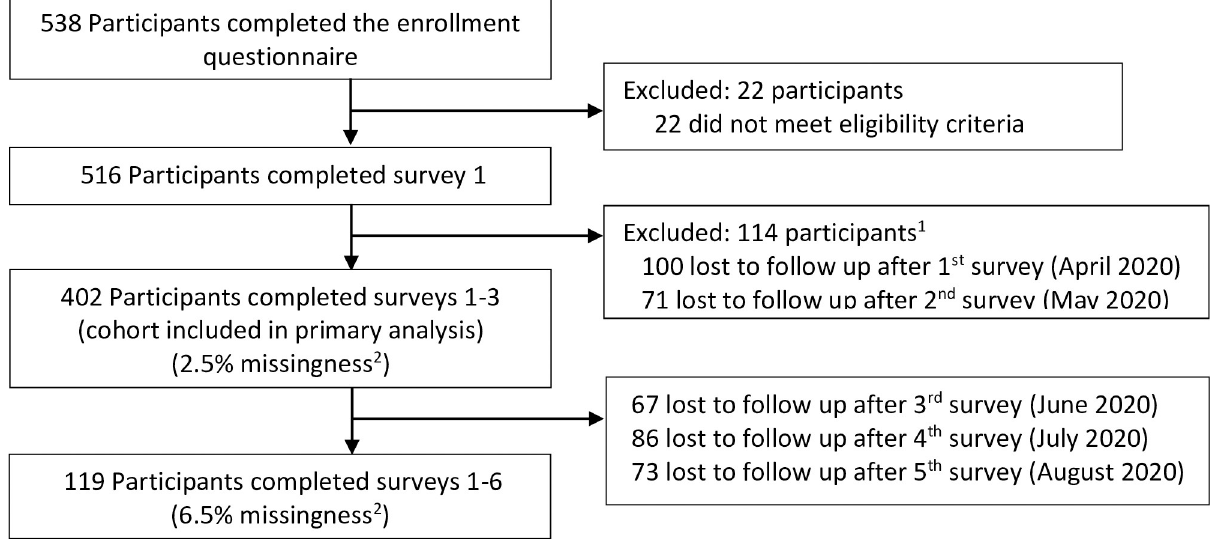
Fig 1. Cohort accrual. 1 Discrepancy between number excluded from primary analysis and number lost to follow-up stems from participants failing to complete consecutive surveys. As data from participants who completed two of the three initial surveys was included in the primary analysis, some individuals may have cursorily been considered lost to follow up after survey 1 but been included in the analysis if they returned to complete survey 3. 2 Within survey missingness.